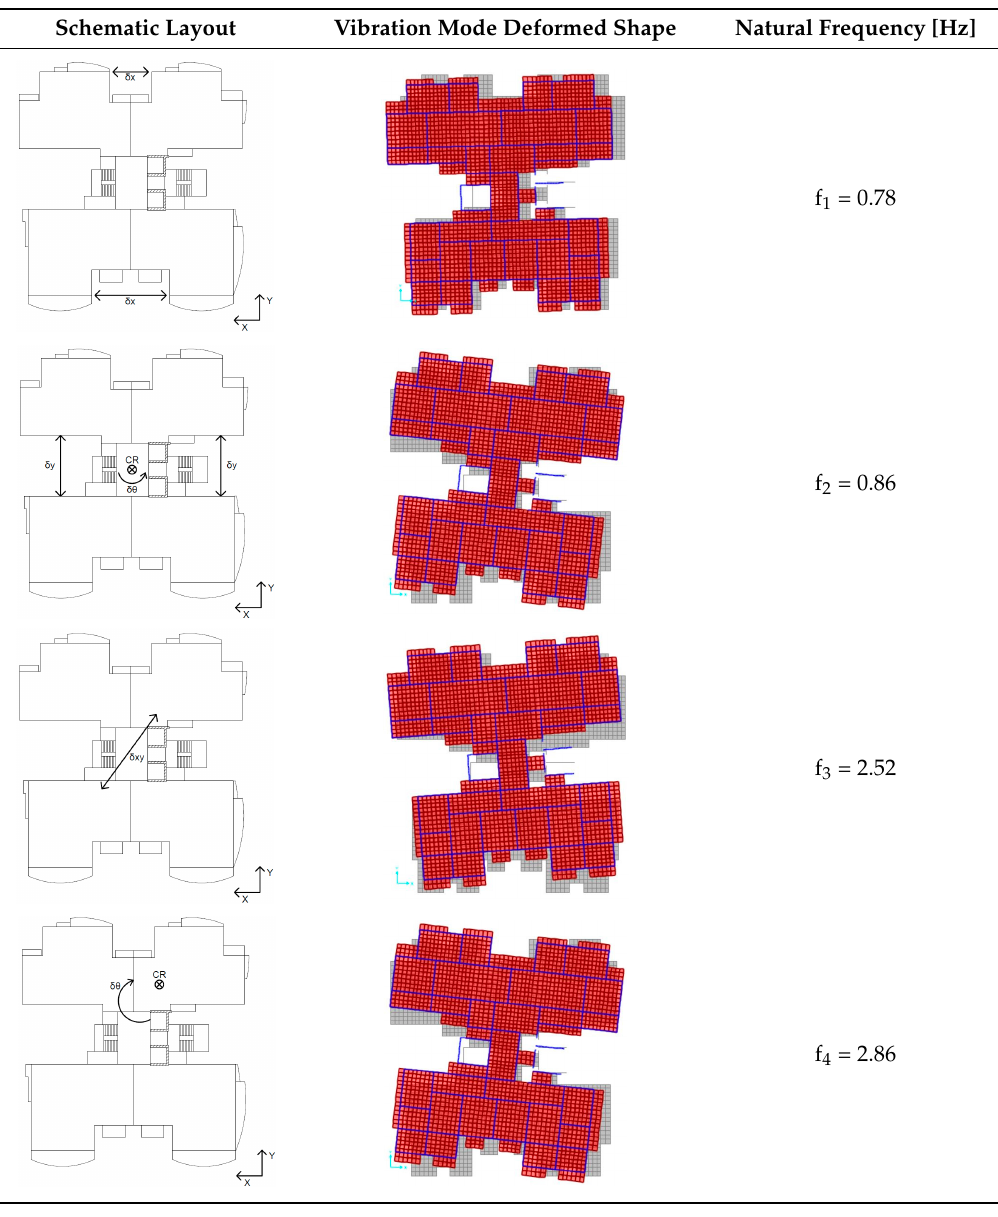
Table 5. Modal analysis results: model with undamaged infill masonry